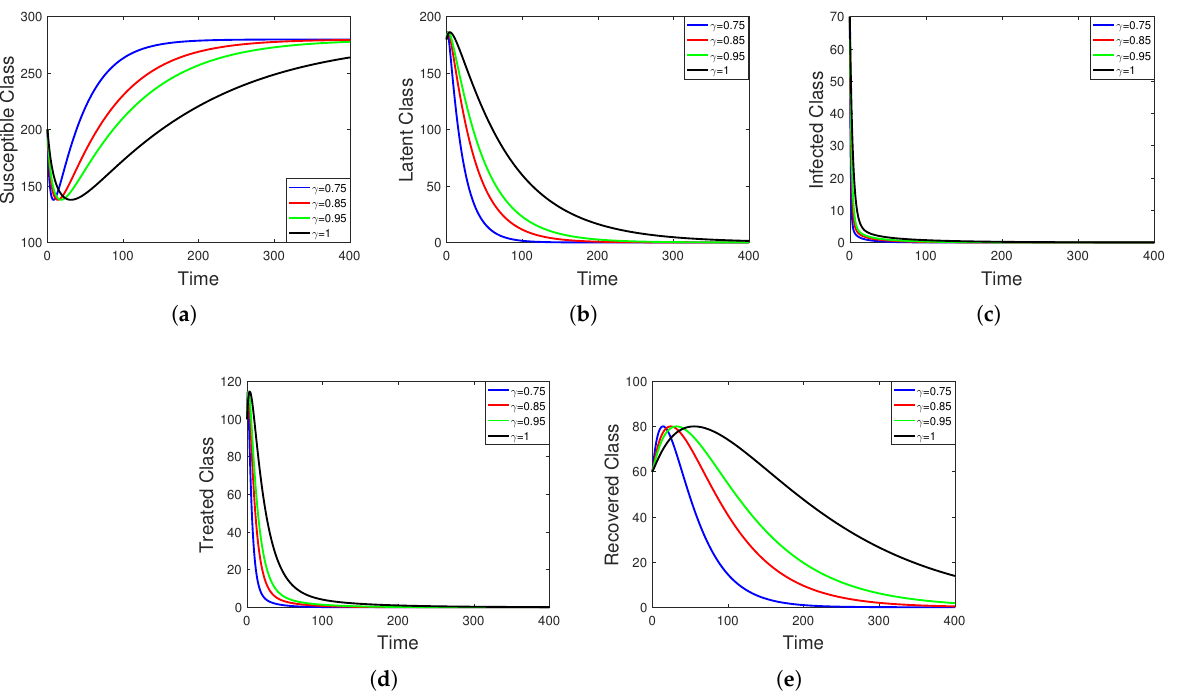
Figure 4. A graphical representation of human society ( a – e ) for different arbitrary orders γ = 0.75, 0.85, 0.95, 1 for initial data and time duration of TB model by taking the value of λ =